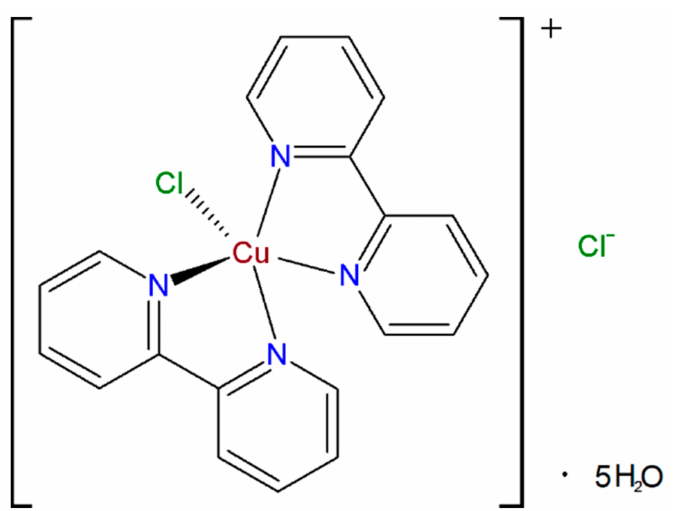
Figure 1. Chemical structure of [Cu(bipy) 2 Cl]Cl · 5H 2 O